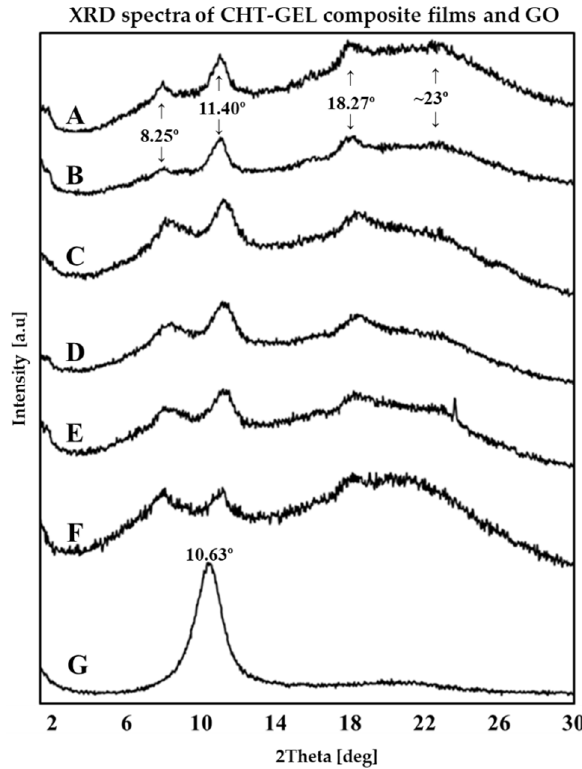
Figure 2. XRD spectra of CHT-GEL ( A ), CHT-GEL-GEN ( B ), CHT-GEL-GEN-GO05 ( C ), CHT-GEL-GEN-GO1 ( D ), CHT-GEL-GEN-GO2 ( E ), CHT-GEL-GEN-GO3 ( F ), graphene oxide powder ( G ).